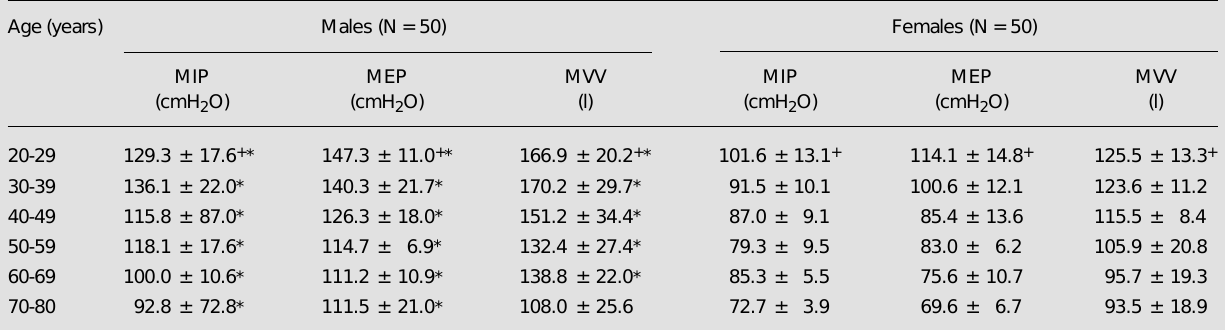
Table 1 - Maximal respiratory pressures and voluntary ventilation in males and females by age group. MIP = Maximal inspiratory pressure; MEP = maximal expiratory pressure; MVV = maximal voluntary ventilation. Data are reported as mean ± SD. + Significant effect among age groups within sex (P<0.05); 20-29 age group vs 40-49, 60-69 and 70-80 groups. * Significant effect between sex groups (P<0.05); males vs females by